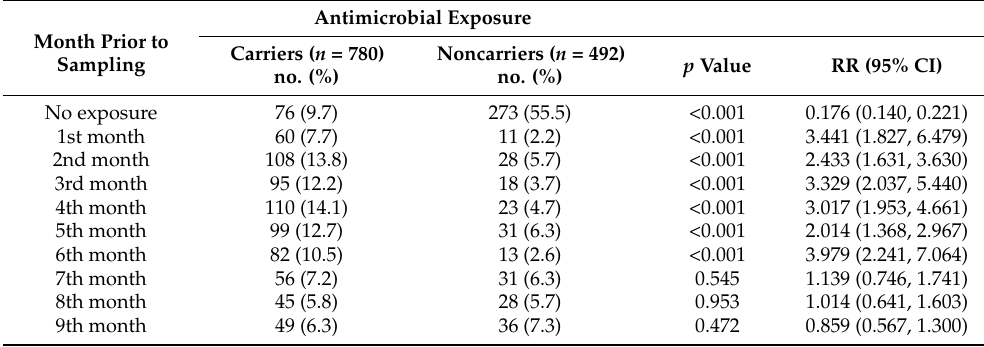
Table 3. Time of prior antimicrobial use and intestinal ESBL-PE carriage in the